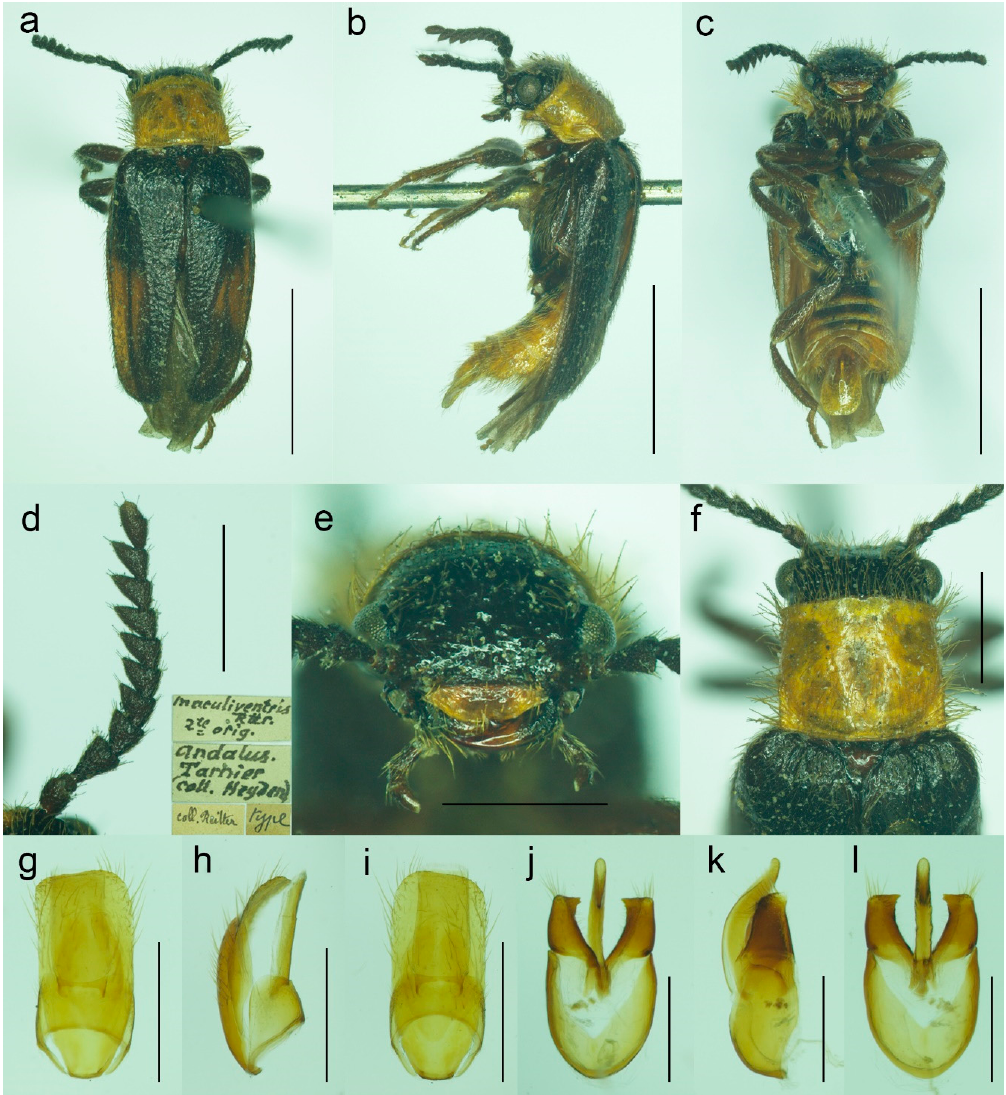
Figure 9. Malacogaster maculiventris Reitter, 1894, male lectotype. ( a ) Habitus, dorsal view; ( b ) habitus, lateral view; ( c ) habitus, ventral view; ( d ) right antenna; ( e ) head, frontal view; ( f ) pronotum, dorsal view; ( g ) genital capsule formed by tergites IX and X, and sternite IX, dorsal view; ( h ) genital capsule formed by tergites IX and X, and sternite IX, lateral view; ( i ) genital capsule formed by tergites IX and X, and sternite IX, ventral view; ( j ) aedeagus, dorsal view; ( k ) aedeagus, lateral view; ( l ) aedeagus, ventral view. Scale bars = ( a – c ) 3.0 mm; ( d – i ) 1.0 mm; ( j – l ) 0.5